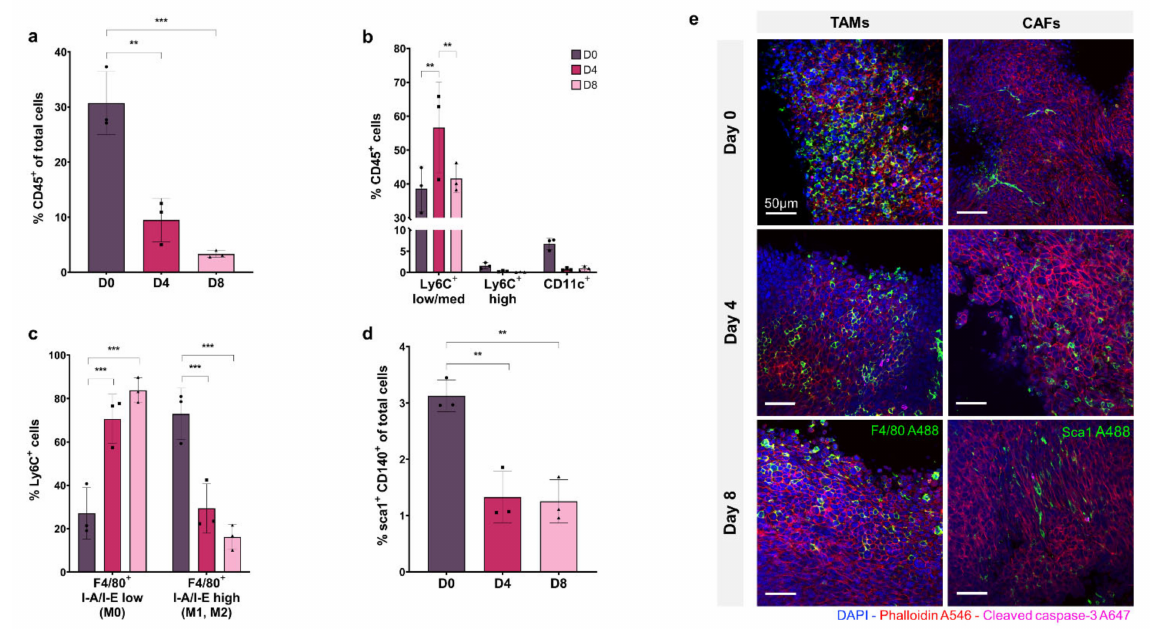
Figure 2. Flow cytometry analysis and fluorescent microscopy of organotypic slices cellular sub-populations at day 0, 4, and 8. ( a ) CD45+ immune cells as a % of total cells. ( b ) Breakdown of mononuclear phagocyte cells as a % of CD45+ population with Ly6C+ low/med macrophages, Ly6C+ high monocytes, and CD11c+ dendritic cells. ( c ) Breakdown of Ly6C+ F4/80+ I-A/I-E low non-activated macrophages and F4/80+ I-A/I-E high activated macrophages (M1, M2). ( d ) sca1+ CD140+ CAFs as a % of total cell population. ( e ) Organotypic slices labelled with DAPI (nuclei, blue), phalloidin (F-actin, red), cleaved caspase-3 (apoptosis, pink), and F4/80 (macrophage marker, green) or sca1 (CAF marker, green). Data is expressed as Mean ± SD of n = 3 samples. p -values; ** p ≤ 0.01, *** p ≤